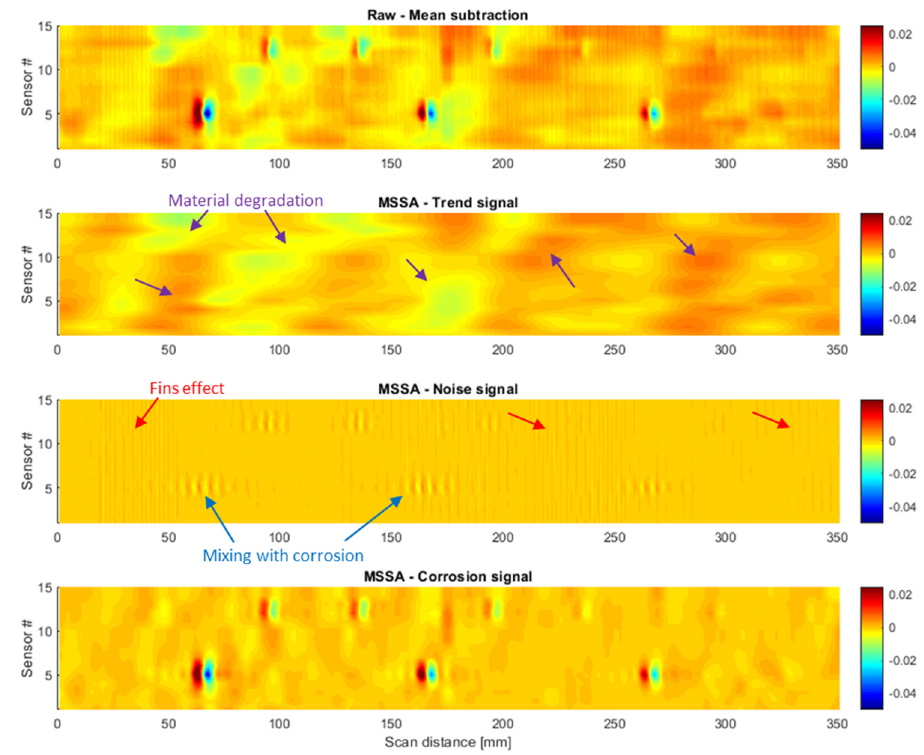
Figure 8. Decomposition of the multivariate magnetic scanned signal into trend signal, noise signal and corrosion signal by the MSSA.